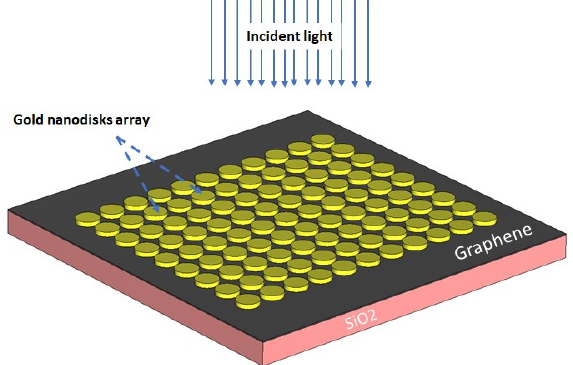
Figure 9. A schematic diagram of the proposed nanosensor associated with the optical stimulation signal.